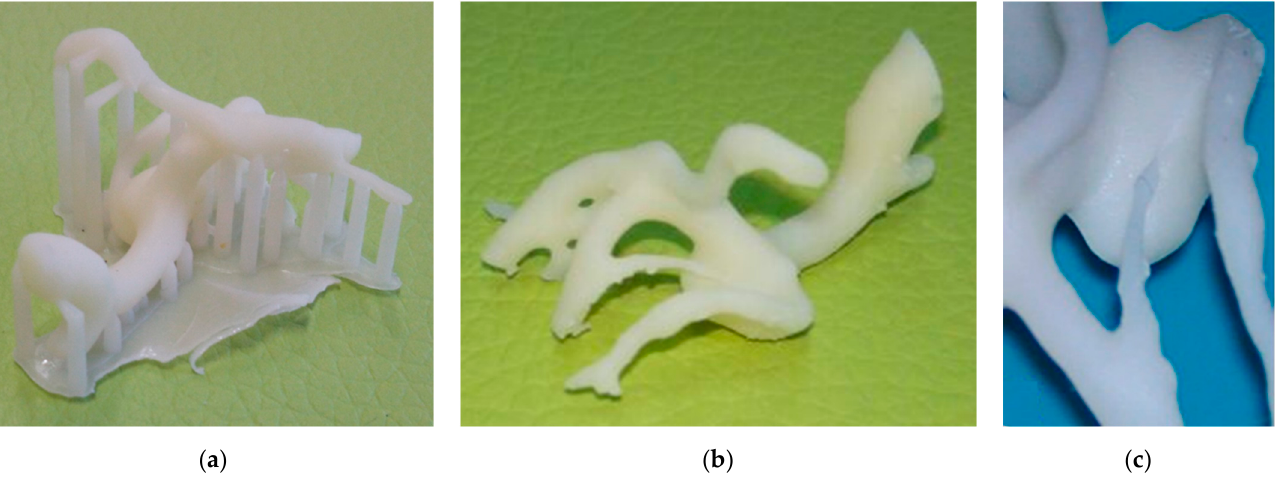
Figure 4. Patient #1 aneurysm reproduction: ( a ) 3D printed model showing the support structures; ( b ) 3D printed model after the removal of the support structures; ( c ) a particular of the back side of the aneurysm showing a possible adherence between the dome of the aneurysm and the frontal branch.